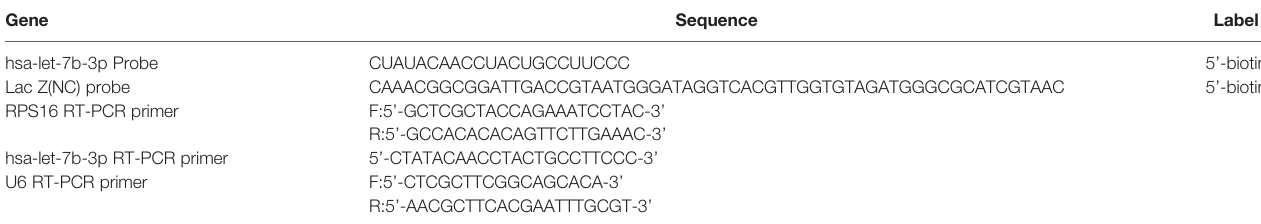
TABLE 2 | Probe and primer sequences for miRNA pull-down